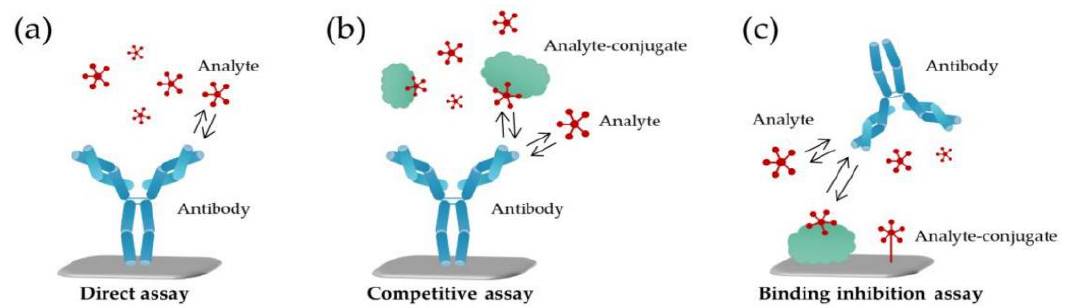
Figure 7. Schematic representation of different assay formats in the detection of small molecules. ( a ) In a direct assay, target analyte attaches to the antibody (recognition element) immobilized on the sensor surface; ( b ) in a competitive assay, the analyte competes with its conjugate to attach to the antibody; ( c ) in a binding inhibition assay, the analyte conjugate is the one immobilized on the sensing surface [94]. (Licensed CC BY 4.0).